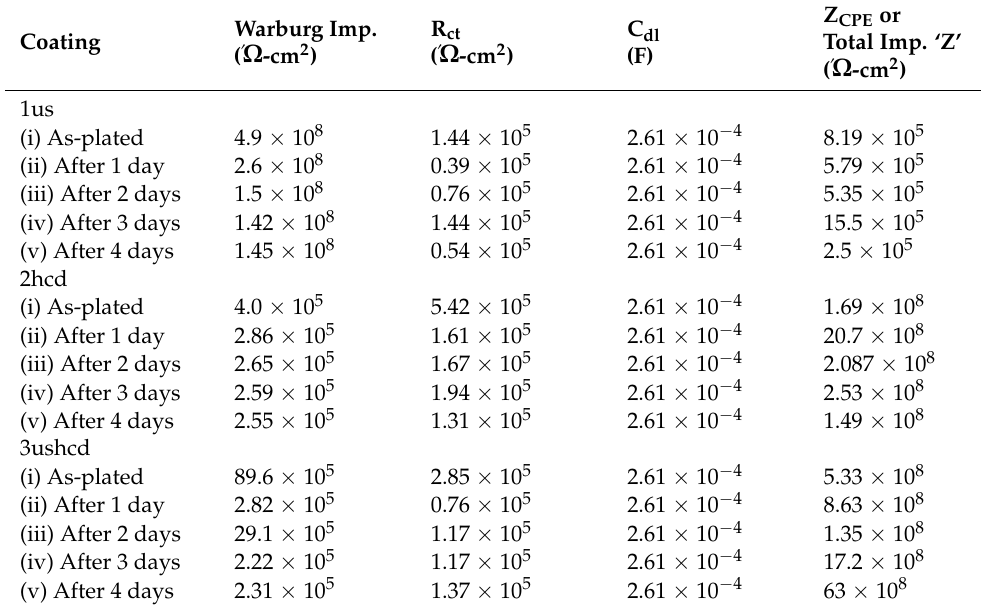
Table 3. Results of ac